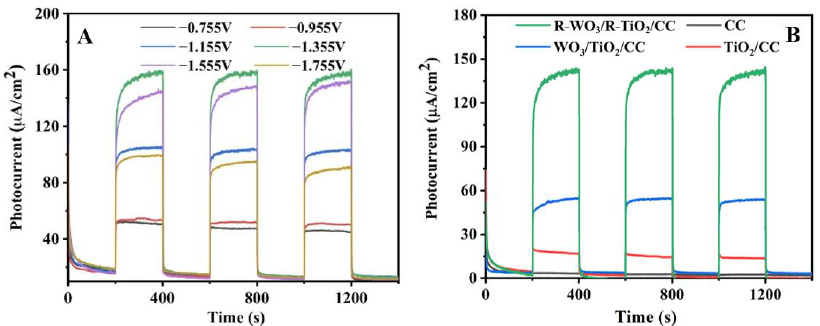
Figure 5. Comparison of photocurrent responses of R-WO 3 /R-TiO 2 /CC under visible light irradia- tion at different cathodic voltages (vs. RHE) ( A ) and different nanomaterials ( B ). Figure 5B shows the comparison of the photocurrent response for CC, TiO 2 /CC, WO 3 /TiO 2 /CC, and R-WO 3 /R-TiO 2 /CC. The flexible CC shows a horizontal line, suggesting